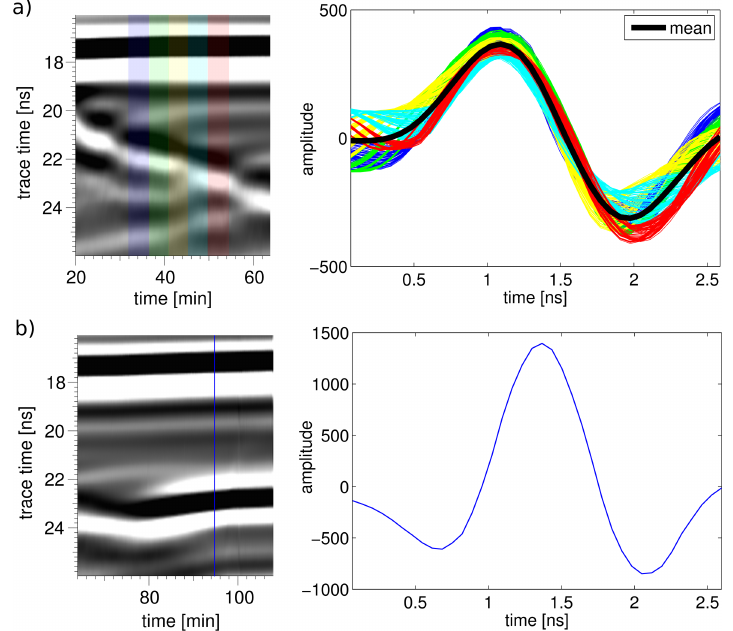
Fig. 3. Comparison of reflections from capillary fringe and compaction: (a) capillary fringe reflection taken from the traces marked in the radargram and the resulting mean value. The reflection is sensitive to interference with reflections from heterogeneities, nevertheless a shape with two significant extrema is observable. (b) Reflection from compaction taken out from the trace marked in the radargram. A shape with three significant extrema is observable.